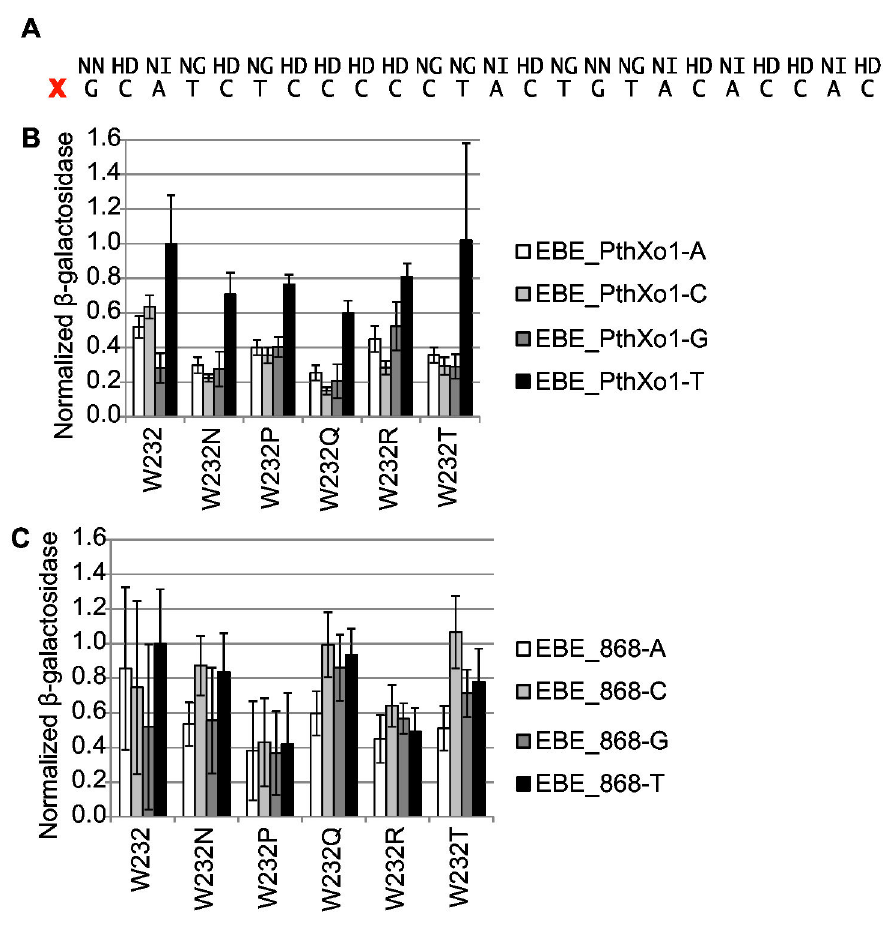
Figure 3. Activity of TALENs with selected single amino acid substitutions for W232 on targets with A, C, G, or T at the 0 th position. A. RVD sequence of the golden gate-assembled PthXo1 equivalent and nucleotide sequence of the PthXo1 EBE. X marks the 0 th position. B. Activity of TALENs with the PthXo1 equivalent RVD sequence, in a yeast single strand annealing assay [14]. EBE_PthXo1-A, EBE_PthXo1-C, EBE_PthXo1-G, and EBE_PthXo1-T indicate activity on targets with paired PthXo1 EBEs each with A, C, G, or T at the 0 th position, respectively. Data are normalized to PthXo1 on EBE_PthXo1-T. Values are the mean of seven or more replicates. Error bars represent s.d. See Table S8 for p -values.